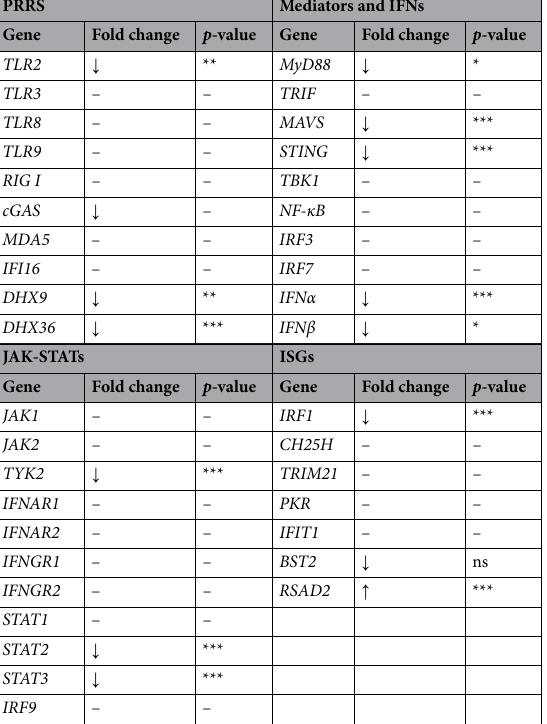
Table 1. Summarized comparison of immune gene expression between Mx2 siRNA and NC siRNA- transfected A172 cells with fold change and p -value. ↑ Fold change ≥ 2 in Mx2-depleted A172 cells. ↓ Fold change ≤ − 2 in Mx2-depleted A172 cells. – represents − 2 < Fold change < 2. ns, not significant. * p < 0.05; ** p < 0.01; *** p <